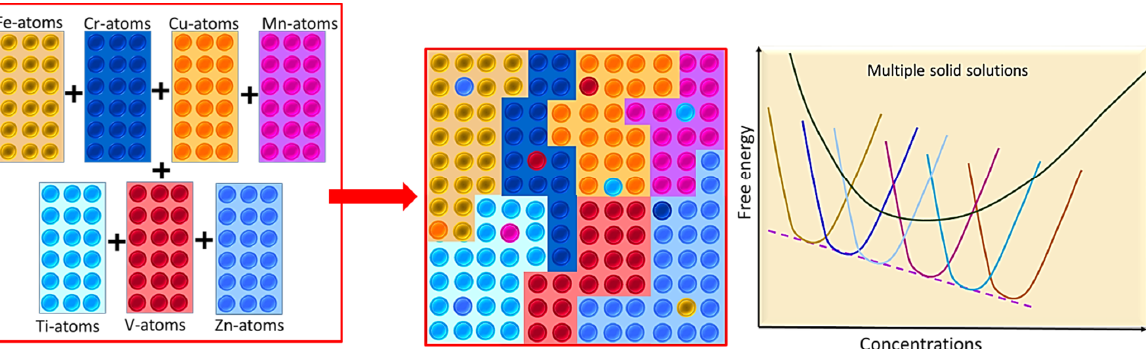
Figure 13. Possible mixing phases among the incorporated equiatomic metallic elements to form multiple solid solutions occurred in the three developed nanostructured HEAs.